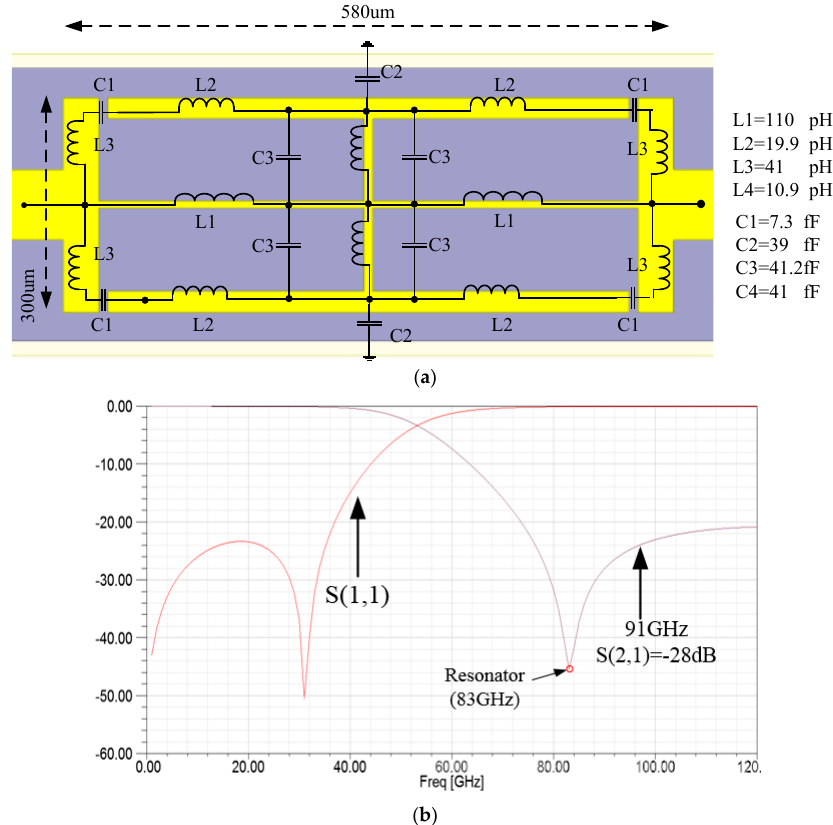
Figure 4. ( a ) Structure of the intermediate-frequency (IF) LPF. ( b ) Simulation performance of the IF